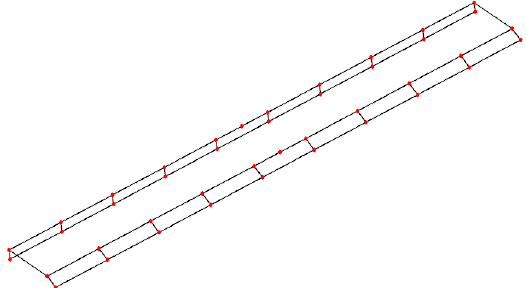
Figure 4. Location of the measurement points on the sensitive plate.